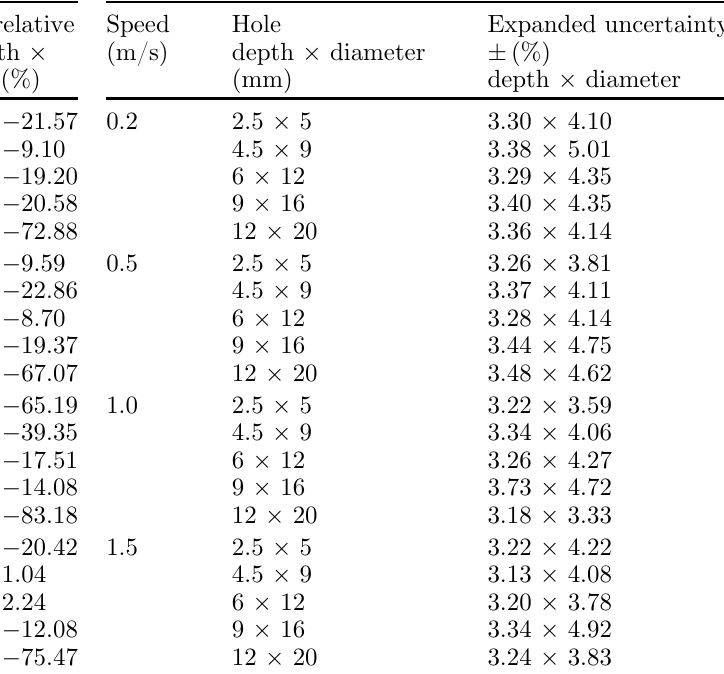
H. Figueiredo Junior et al.: Int. J. Metrol. Qual. Eng. 13 , 15 Table 3. Average of relative error. Table 4. Final uncertainties.